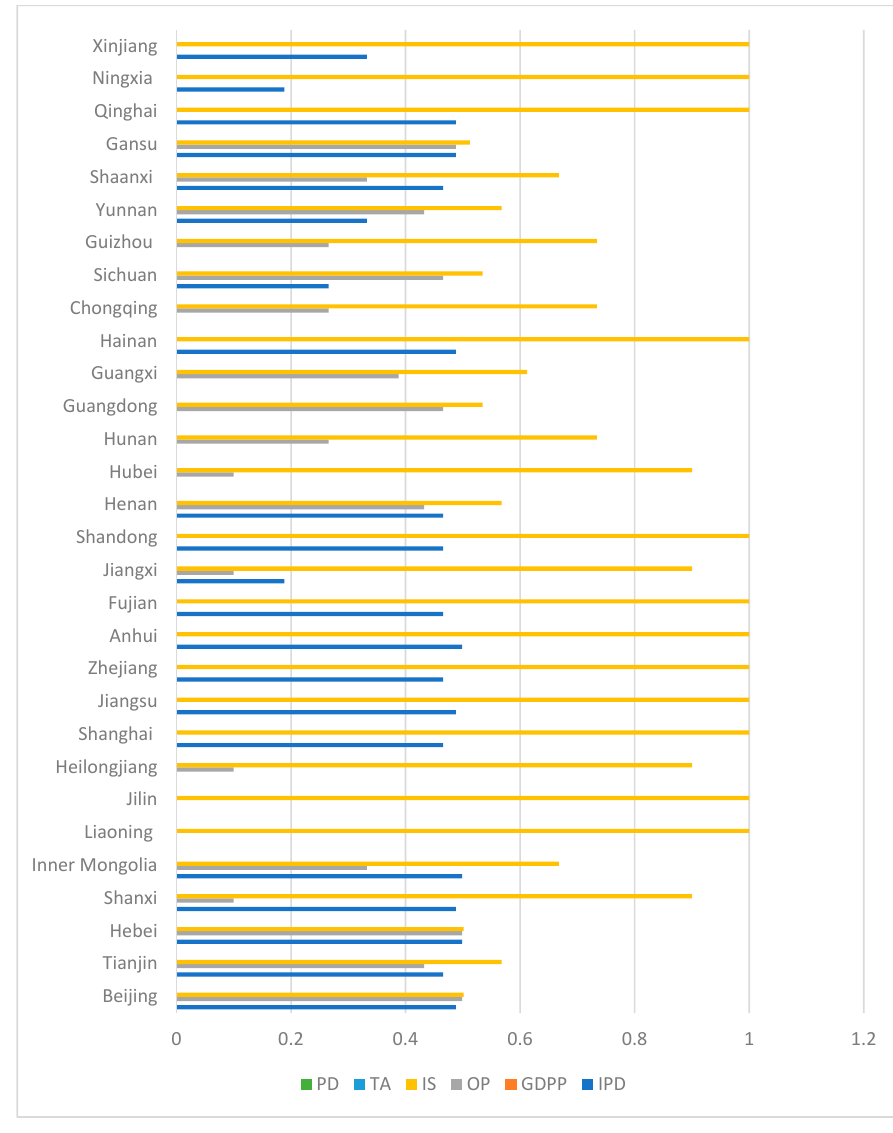
Figure 7. Temporal heterogeneity in spatial dimension.